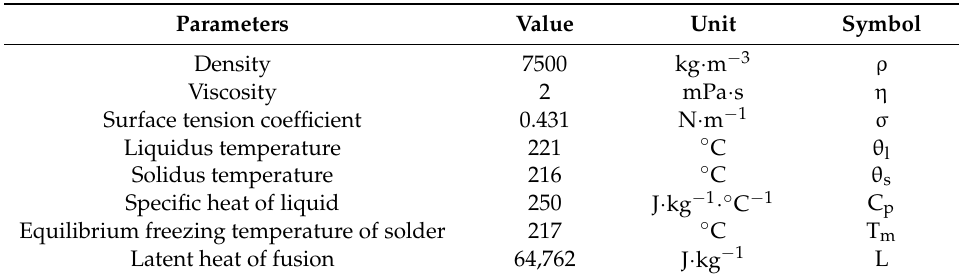
Table 1. Thermal and physical properties of Sn-3Ag-0.5Cu used in the formula for the experimental calculating